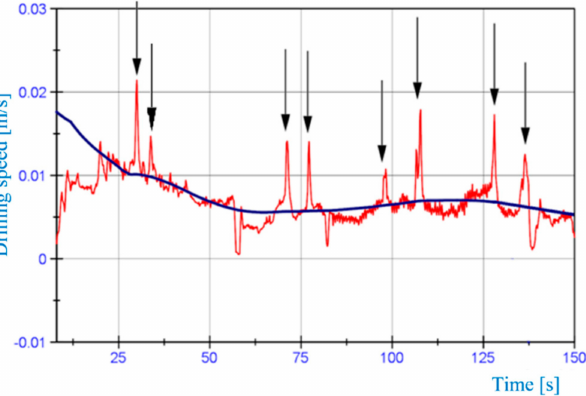
Figure 11. Drilling speed for the first rod of borehole No. 2 marked with the value of a moving